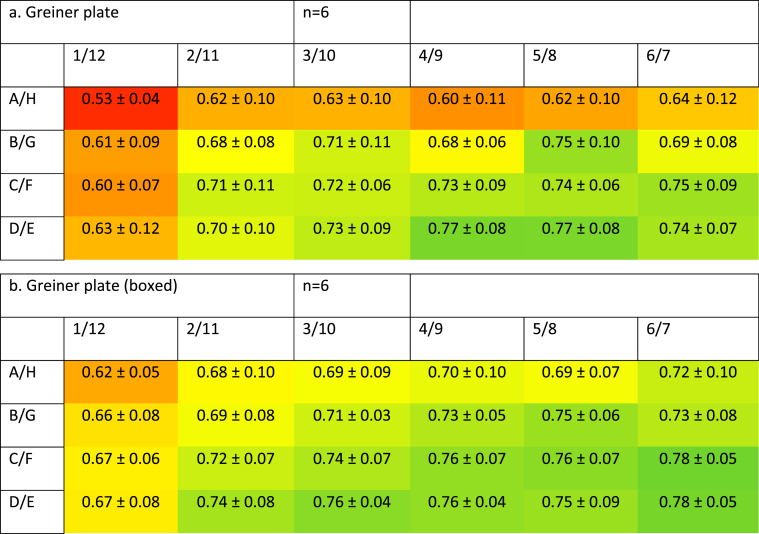
Profile of metabolic activity of cells grown in Greiner plates. SW480 cells were grown for 72 h before being subjected to an MTS proliferation assay. Data show absorbance (490 nm) increase and standard deviation of sample data following a 2-h incubation in the presence of MTS reagent and represent n = 6 (3a) or 8 (3b). 3a: incubated alone. 3b: incubated with packaging.